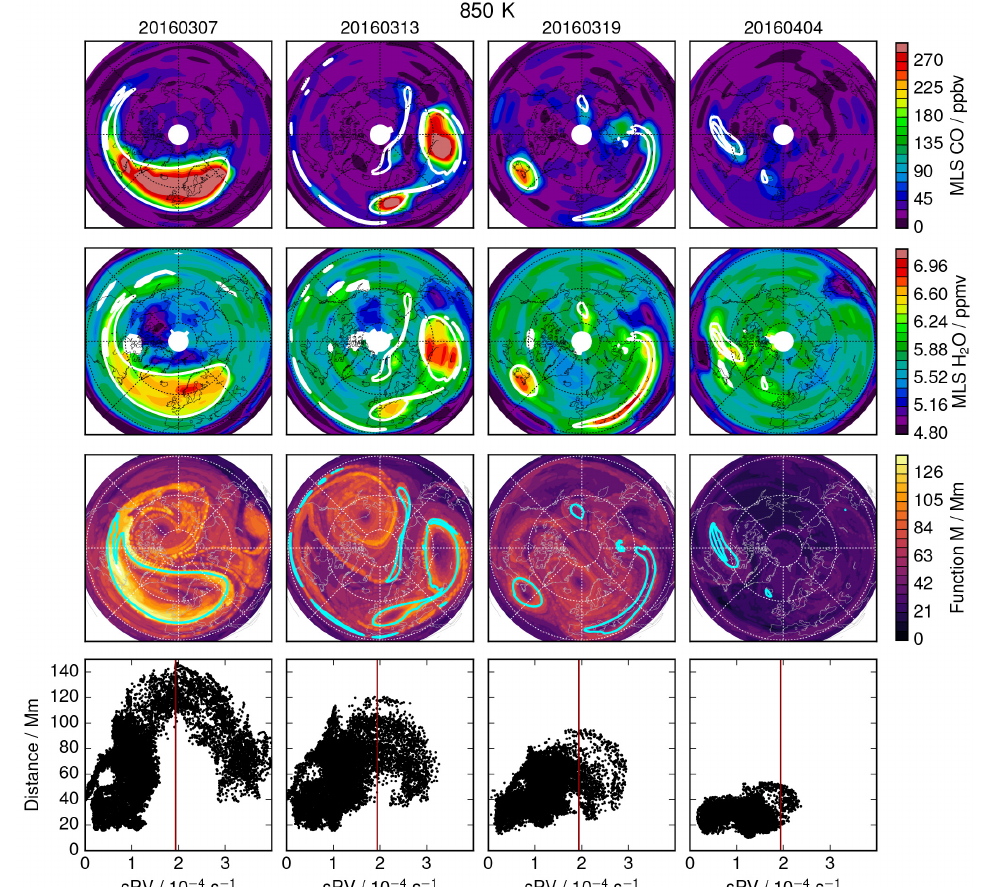
Figure 9. Orthographic maps of 850K MLS CO (first row) and H 2 O (second row), and function M from MERRA-2 (third row), along with scatterplots of M vs. scaled potential vorticity (fourth row), for individual dates during the major final warming (columns are 7 March, 13 March, 19 March, and 4 April, respectively). The white/cyan contours in the maps and red lines in the bottom row show the sPV value used in CAVE-ART to define the vortex edge at this level. Note that the sPV contours used in the MLS (first two rows) and M (third row) maps are slightly different; the MLS maps show the contour from 12:00UT MERRA-2 PV, whereas the M maps show the value from 00:00UT (see description of M calculation in Sect. 2.4). Also note that the units of M are in megameters (Mm, 10 6 m). Maps show Equator to pole, with 0 ◦ longitude at the bottom and 90 ◦ E to the